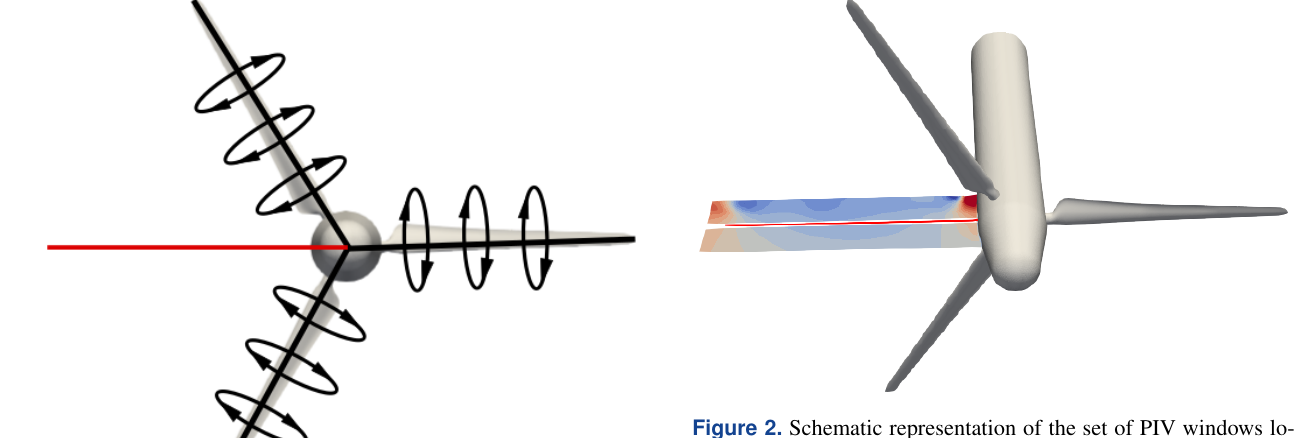
Figure 2. Schematic representation of the set of PIV windows lo- cated at the 3 o’clock position upstream and downstream of the rotor plane. Between both sets of PIV windows there is a gap of approx- imately 30mm, in which the bisectrix between the blades (marked in red) is located. The measurements are phase-locked at 60 ◦ after blade passage, i.e. when one blade is at the 11 o’clock position (as